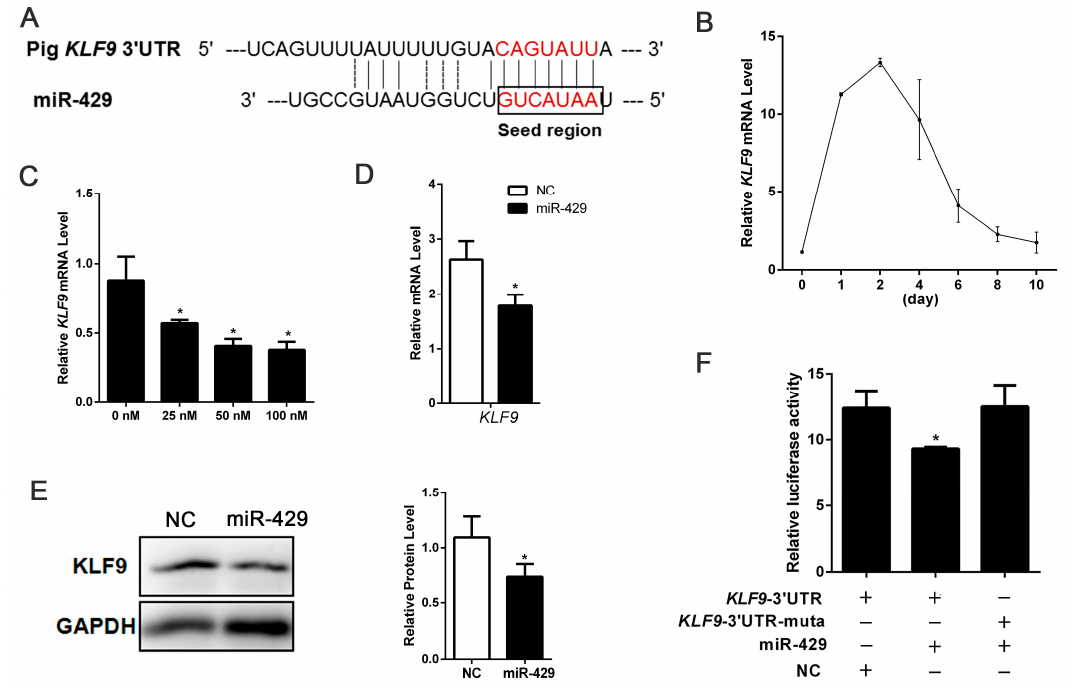
Figure 4. miR-429 can target KLF9 and downregulate the expression of KLF9 in PSPAs. ( A ) Target site of miR-429 within porcine KLF9 mRNA 3 ′ -UTR and mutational site of KLF9 3 ′ -UTR, using CGC replace UAU; ( B ) The expression pattern of KLF9 during porcine subcutaneous preadipocyte differentiation; ( C ) Different concentration miR-429 agomir (0, 25, 50, 100 nM) treated cells, after 48 h of transfection to detect the expression of KLF9 ; The mRNA ( D ) and relative protein ( E ) level of KLF9 were detected on day 2 of PSPAs differentiation; ( F ) KLF9 mRNA 3 ′ -UTR or its mutation dual-luciferase vector was co-transfected with miR-429 agomir/NC into PSPAs. Dual-luciferase assay was performed at 48 h after transfection. Results are indicated as means ± SEM; n = 3; * p < 0.05.